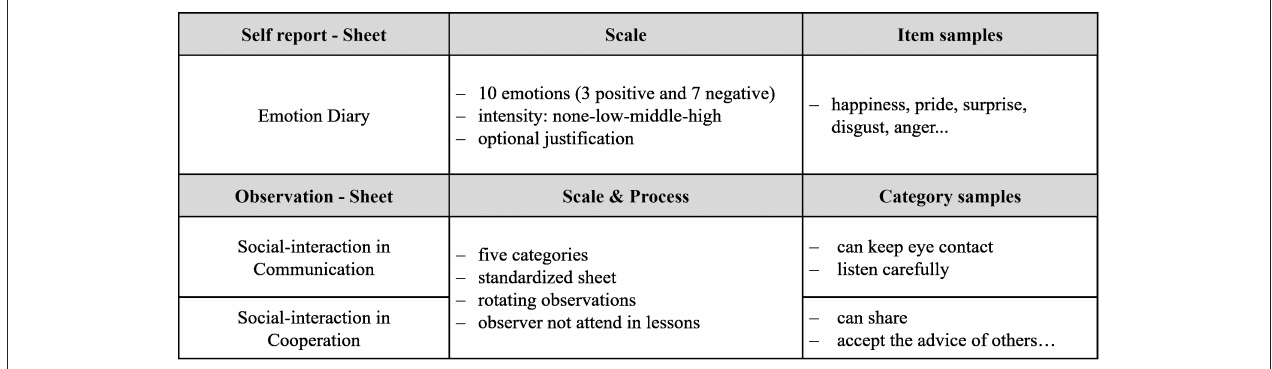
FIGURE 2 | Overview of the